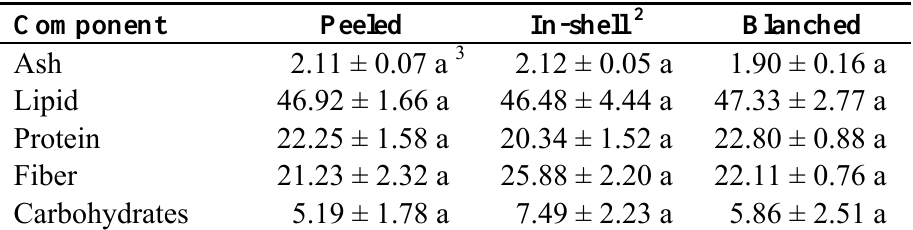
Table 1. Proximate composition 1 (g/100) of dry